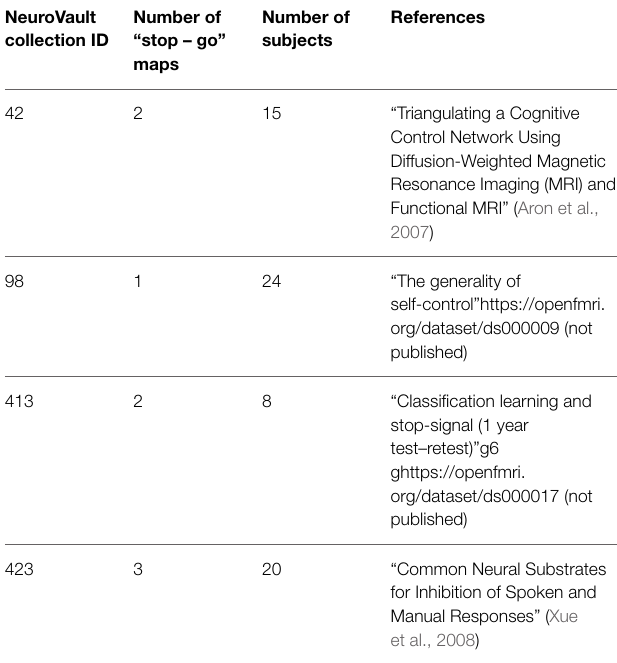
TABLE 1 | Details of the four studies included in the example